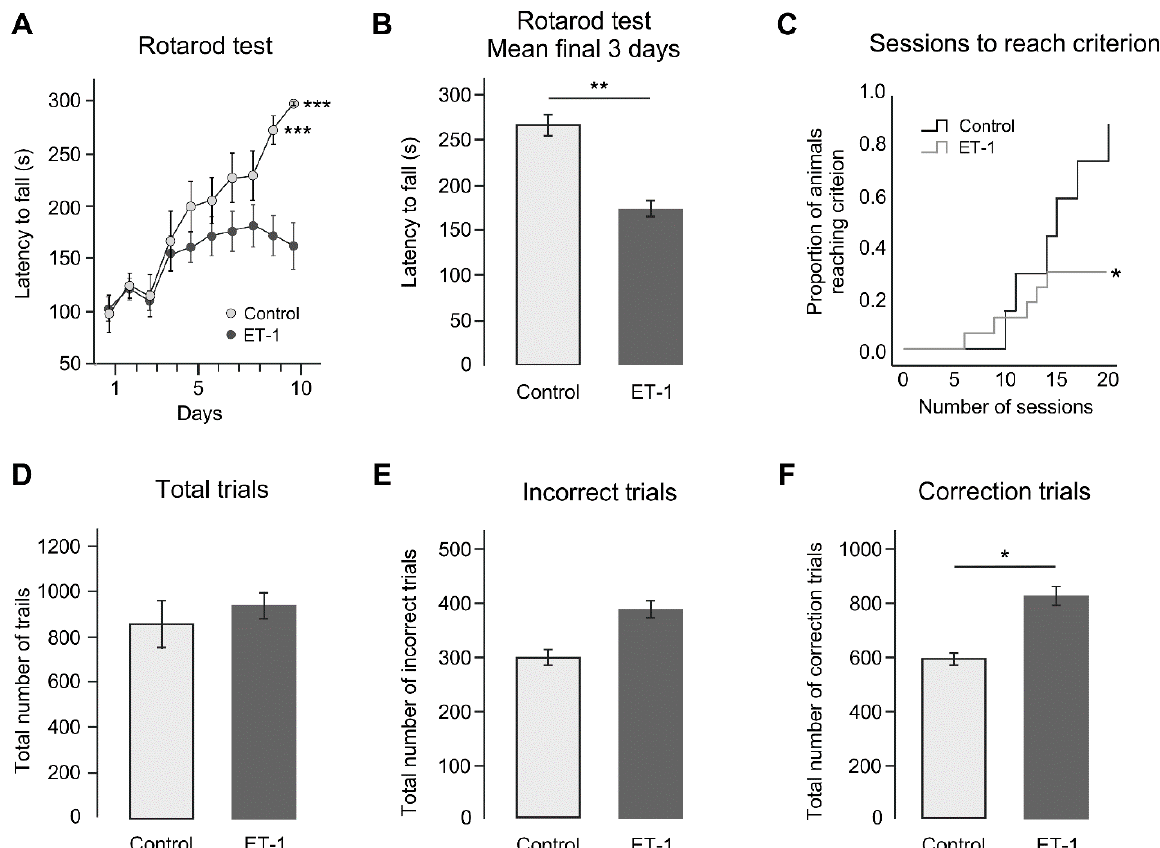
Figure 1. Motor and cognitive changes following early neonatal ischemic injury. ( A ) At 18 weeks of age, latency to fall on the accelerating rotarod over 10 days shows that the control group improves with training to a significantly greater extent compared to ET-1-treated animals. ( B ) Latency to fall on the rotarod represented as average performance over the last 3 days shows the ET-1-treated animals are significantly impaired. ( C ) Proportion of animals reaching the criterion for learning on the pairwise discrimination task over 20 sessions of testing. Less animals in the ET-1 group were able to acquire the learning criterion within 20 sessions. ( D ) Of those animals that did reach the criterion in both control and ET-1 groups, no significant differences could be observed for the total trials taken to reach the criterion. ( E ) Total number of incorrect responses and ( F ) correction trials for all animals tested showed the ET-1 group performed more correction trials than the control group. Error bars = 1 SEM, * p < 0.05, ** p < 0.01, *** p < 0.001, independent t -test, (Group size: Control n = 7; ET-1 lesion n = 17).